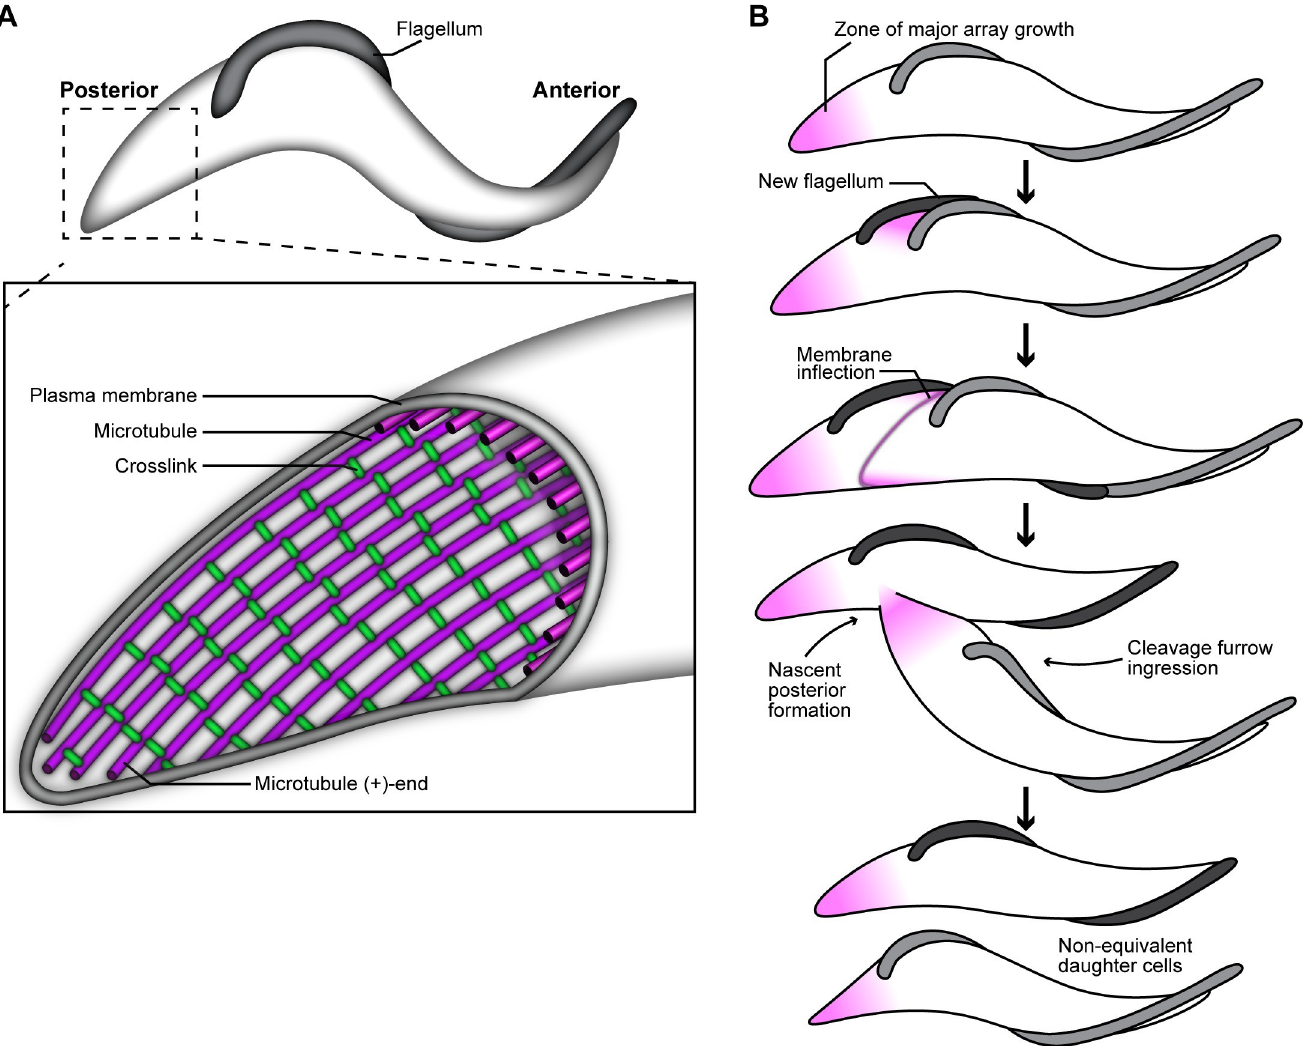
Fig 1. Schematics of the cytoskeleton and cell division in Trypanosoma brucei . (A) The subpellicular array is a single layer of microtubules (purple) that underlies the plasma membrane. The microtubules are crosslinked to each other by regularly spaced fibrils (green). The growing plus-ends of array microtubules face the cell posterior. (B) Array microtubules appear to consistently polymerize at the posterior end of the cell (purple shading). As the new flagellum is nucleated, new microtubules are inserted between the old and new flagellum to increase cell width. A membrane inflection forms that demarcates the path of cleavage furrow ingression, which follows the helical path of array microtubules. Cleavage furrow ingression initiates at the cell anterior, and nascent posterior end formation remodels the array at the cell midzone to resolve the subpellicular array into two distinct structures to complete cytokinesis.